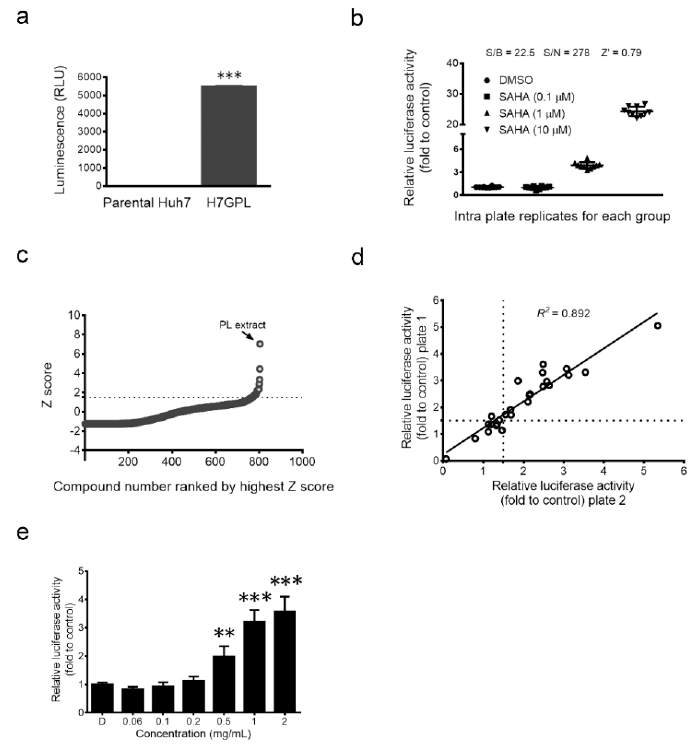
Figure 1. Establishment of a drug screening platform for high-throughput screening. ( a ) Huh7 GNMT promoter-luciferase (H7GPL) stable clone and parental human hepatoma Huh7 cells were harvested for luciferase activity measurement. Results are the means ± SD ( n = 3); ( b ) Well-to-well reproducibility ( n = 10) and dose response of Glycine N -methyltransferase (GNMT) promoter activity in H7GPL cells treated with Dimethyl sulfoxide (DMSO) or suberoylanilide hydroxamic acid (SAHA). Relative luciferase activity was calculated by normalizing luciferase activity to cell viability and presented as the fold to control after 24 h of drug treatment; ( c ) Primary screening plot shows the distribution of the Z score; the dashed line shows the cut off value ( Z score > 1.5), and dots above this line represent hits; ( d ) XY-scatter plot of relative promoter activity illustrating the compounds that increased GNMT promoter reporter expression in the secondary screen. The cell viability was used to normalize the reporter activity and plotted as the fold to control. The “relative promoter activity Plate 1” and “Relative promoter activity Plate 2” represent the fold change for the two independent replicates of the screen. Dashed lines show the cut off value (fold change > 1.5), and dots above this line in both replicates were considered as hits; ( e ) H7GPL cells were treated with indicated concentrations of PL extract. After 24 h, the relative luciferase activity was determined as described above. The graph shows the means ± SD ( n = 3). *** p < 0.001, ** p < 0.01 (Student’s t -test).